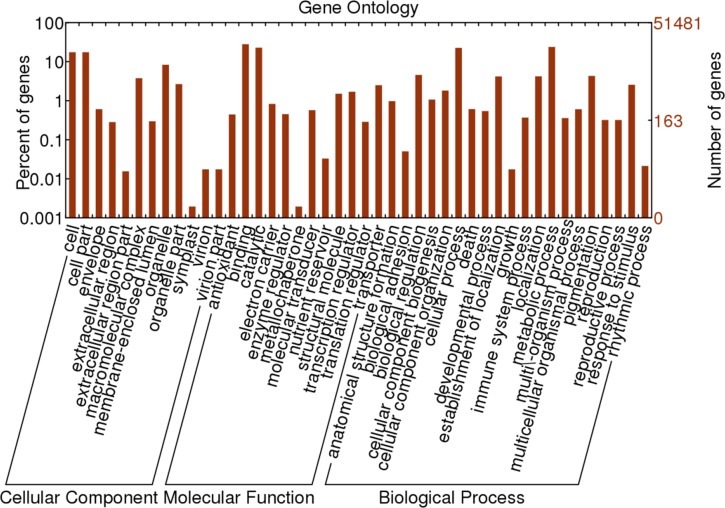
GO classification of ‘Hangbaishao’ unigenes.